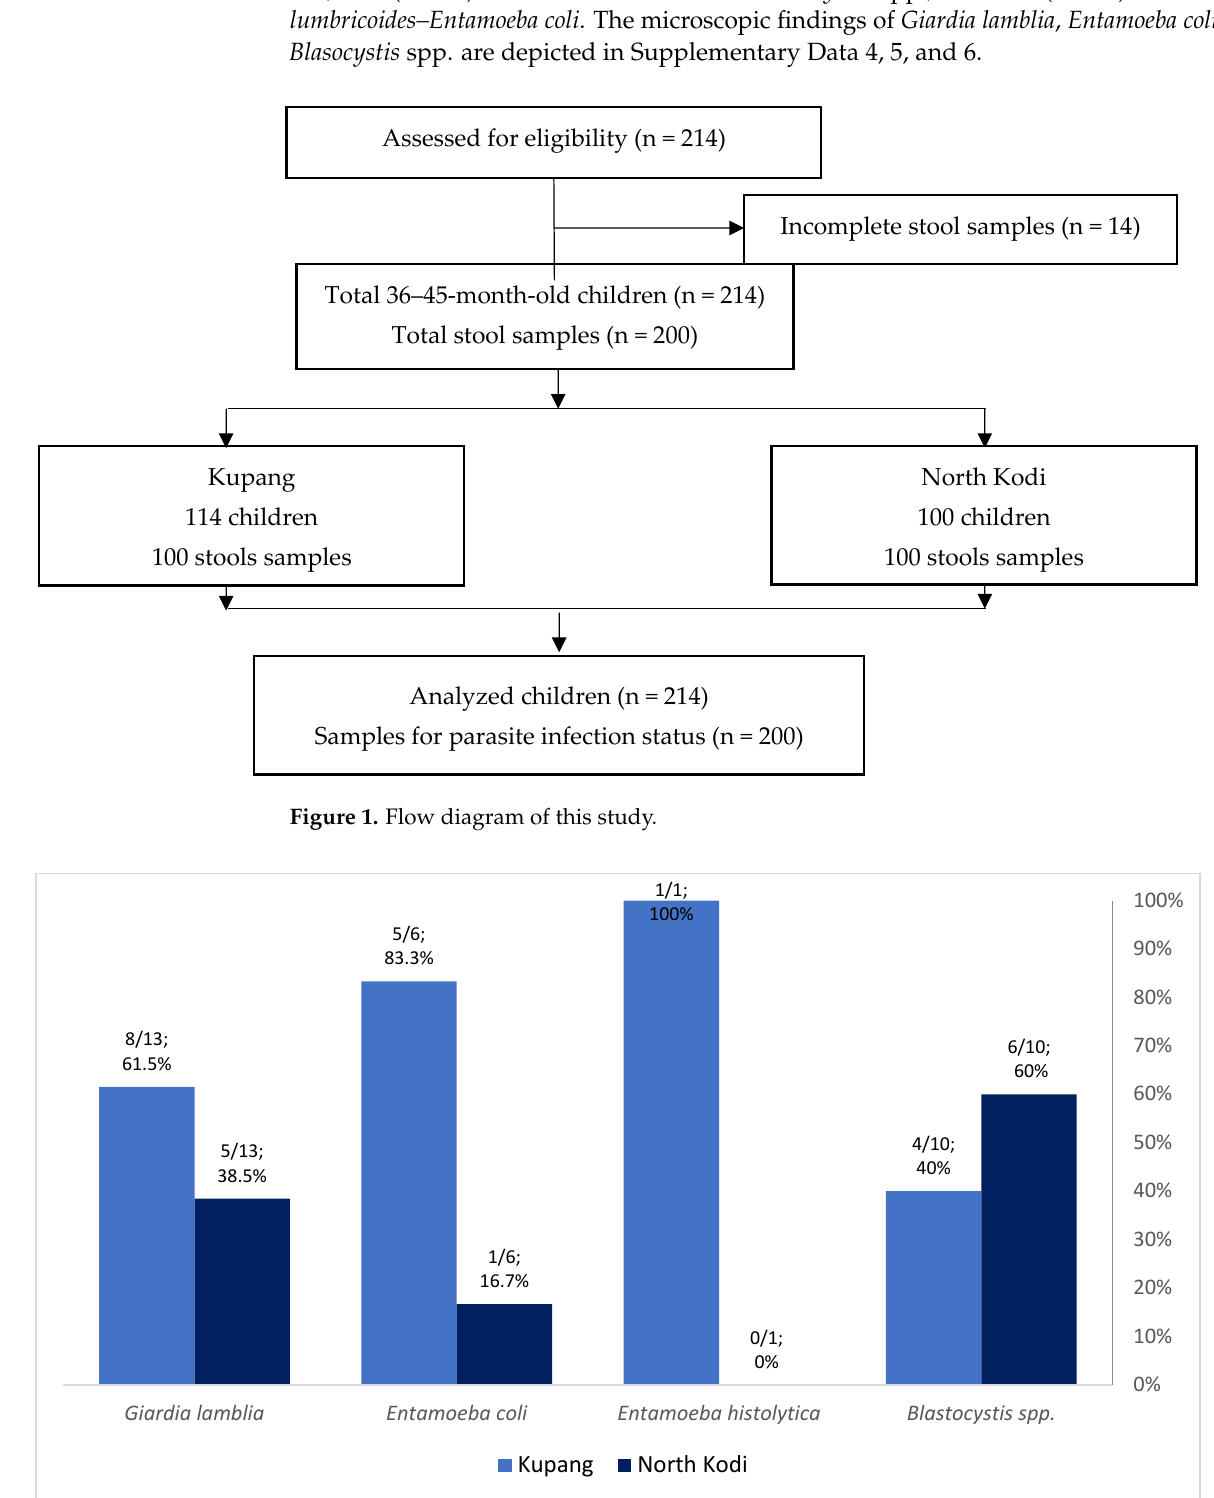
Figure 2. Intestinal protozoan distribution in Kupang and North Kodi, East Nusa Tenggara; n = 30 children. Giardia lamblia was detected in a total of 13 children; Entamoeba coli was detected in a total of 6 children; Entamoeba histolytica was detected in a total of 1 child; Blastocystis spp. was detected in a total of 10 children (one child had ≥ 1 protozoan parasites).